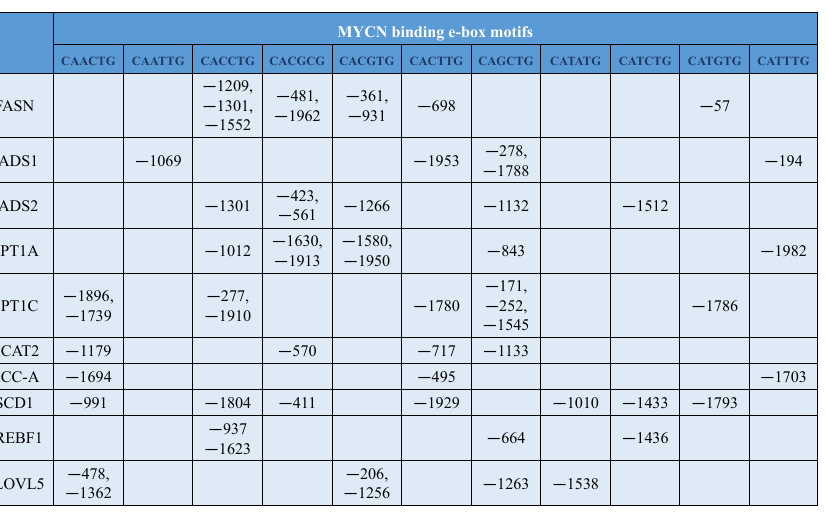
Figure 5. The location of MYCN binding E-box motifs on the promoter region of lipid metabolic